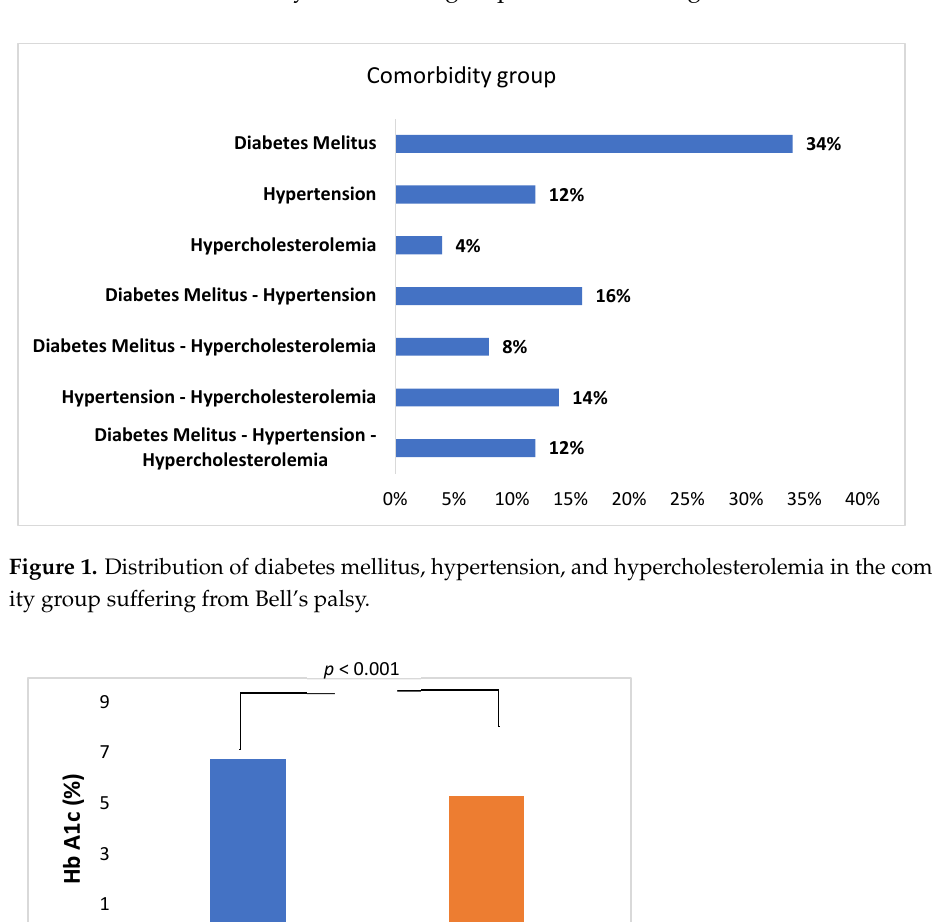
Figure 2. Glycosylated hemoglobin Hb A1c (%) in the comorbidity and control group suffering from Bell’s palsy. Table 1. Mean age by gender of patients suffering from Bell’s palsy for the comorbidity and con- trol group.